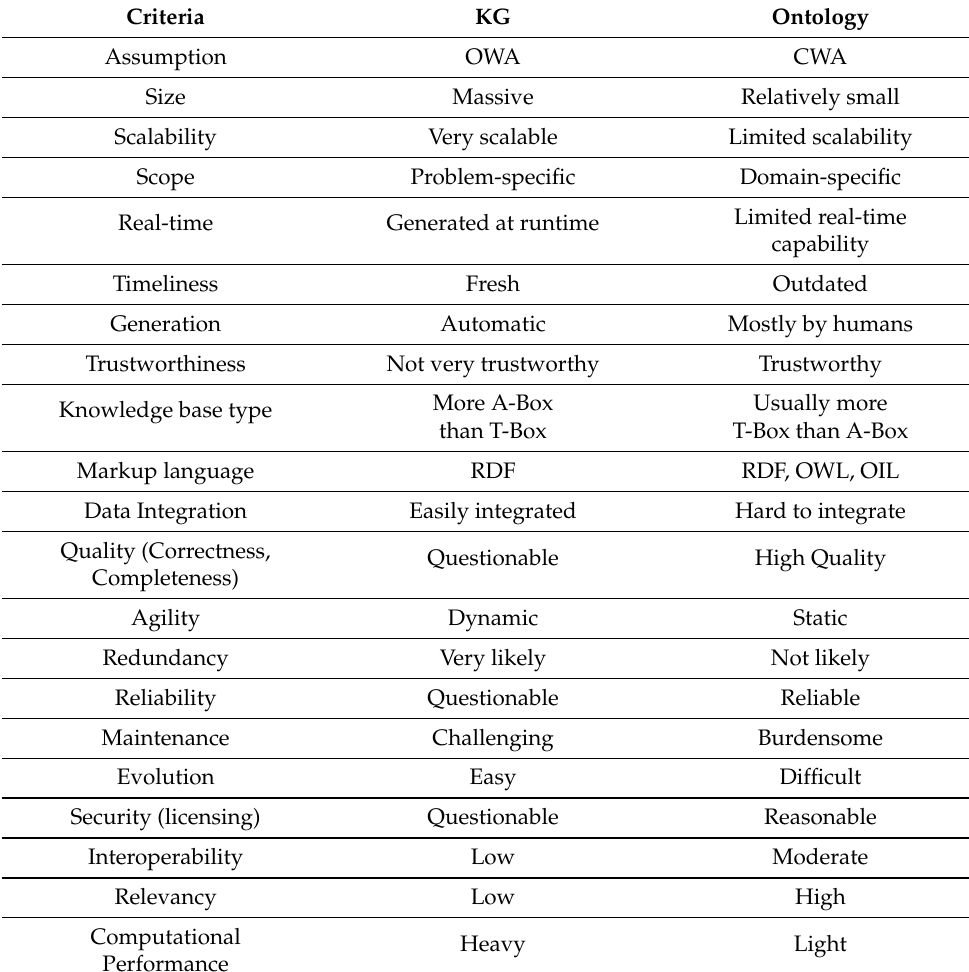
Table 1. Knowledge graph vs. ontology